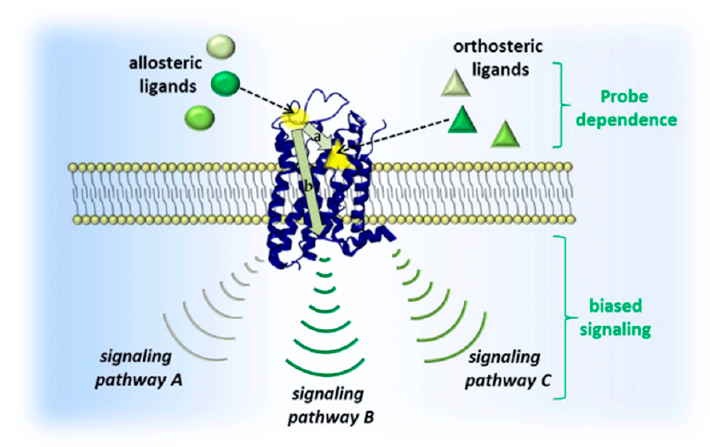
Figure 3. Schematic of GPCR signal transduction: allosteric modulators (spheres) bind to a topographically different site (yellow sphere) than the orthosteric site (yellow triangle) which hosts an orthosteric ligand (triangles). Reproduced with permission from [35].